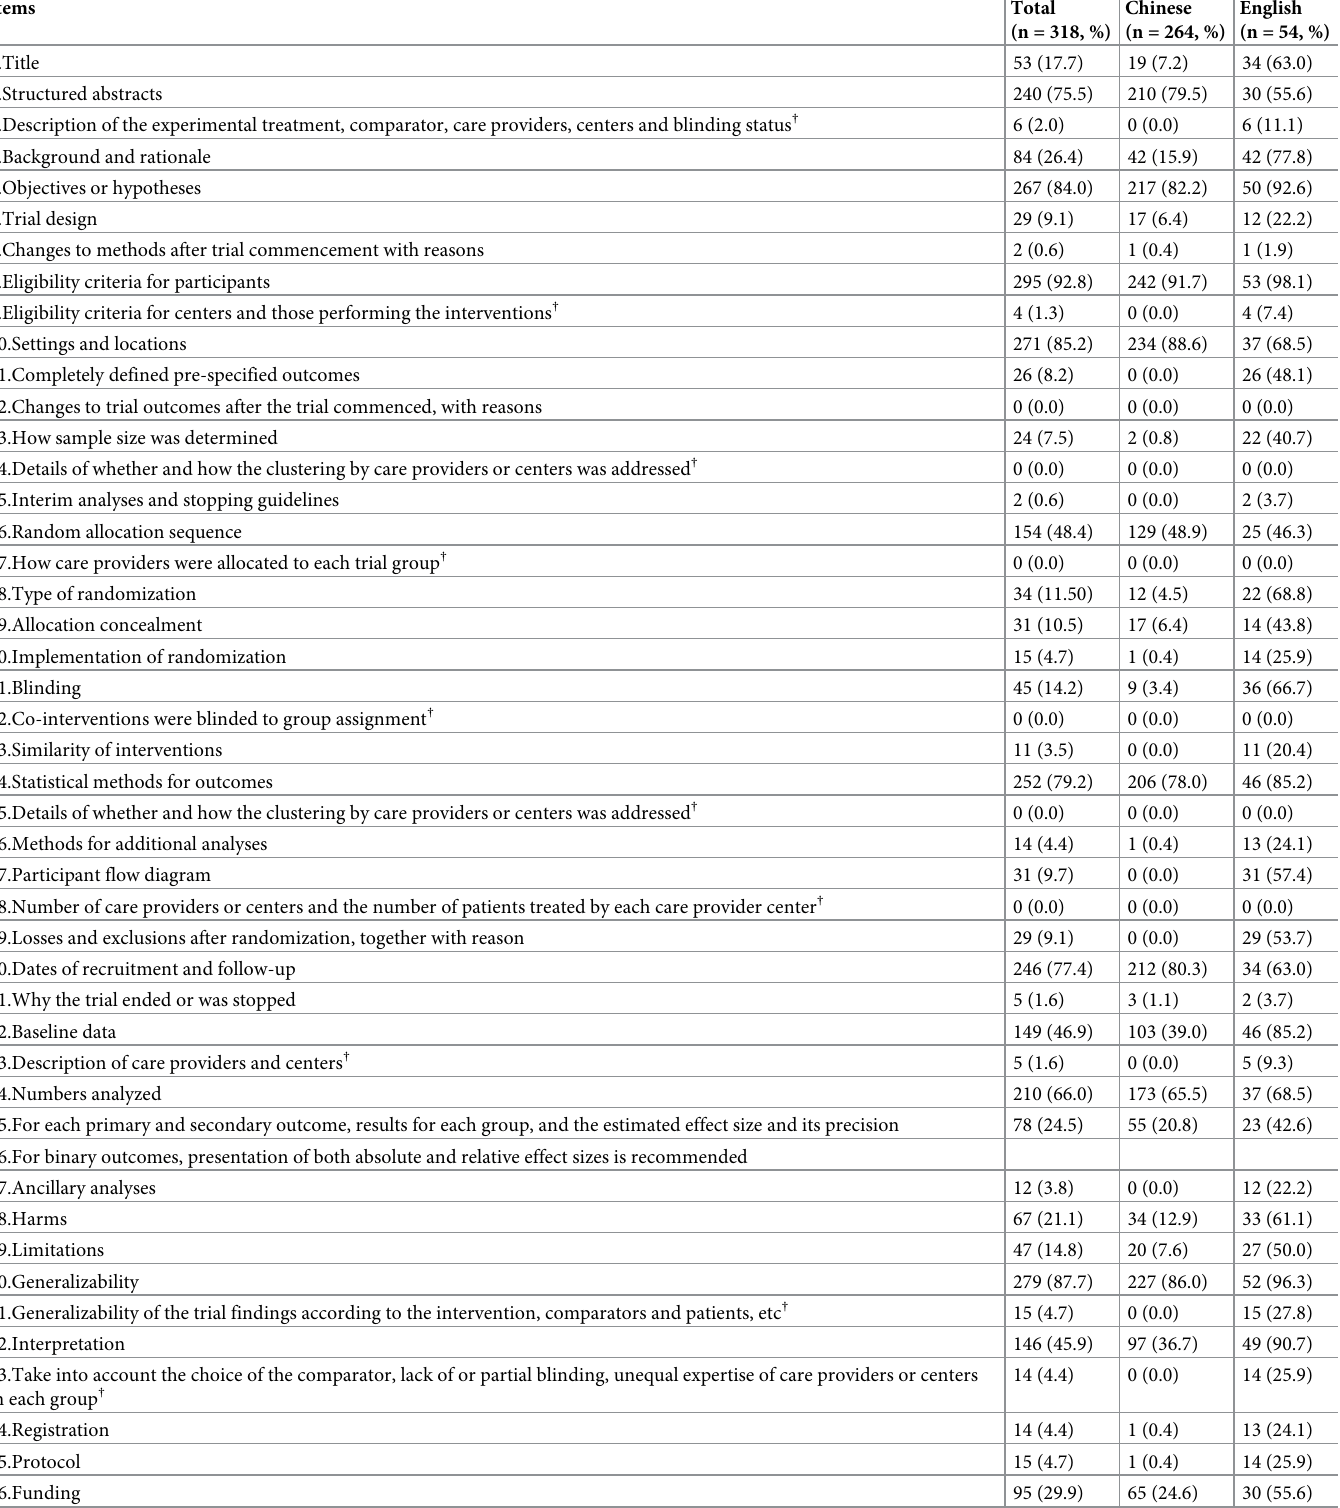
Table 2. Compliance of reporting to the standard CONSORT and CONSORT extension checklists.